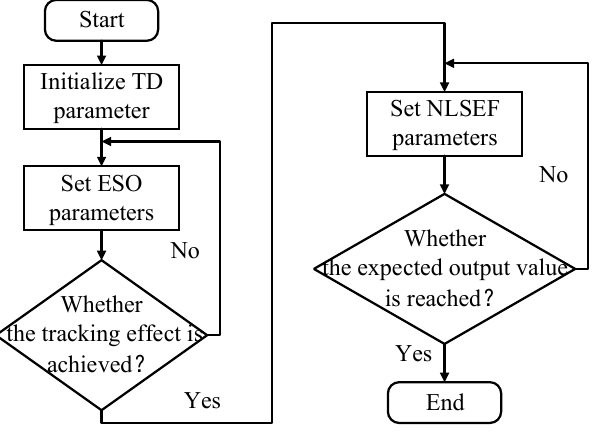
Figure 9. Tuning process of hybrid ADRC